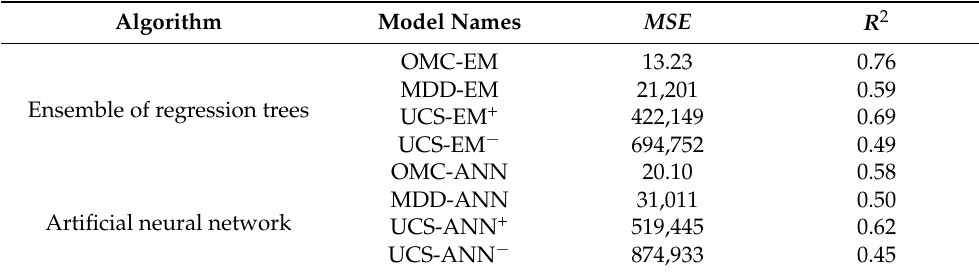
Table 5. Statistical performance measurements for models based on ensemble methods and ANN on unseen